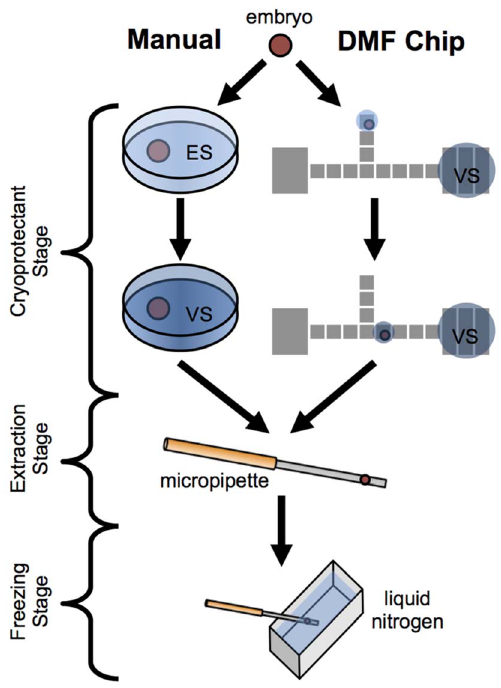
Figure 1. Manual and digital microfluidic vitrification work- flow. Schematic showing differences between manual vitrification approach, which requires manual pipetting between cryoprotectant mediums, and the digital microfluidic (DMF) approach, which moves the embryo between mediums on chip. The chip automates the high skill portion of the procedure providing labor cost savings and opportunities for parallel processing.